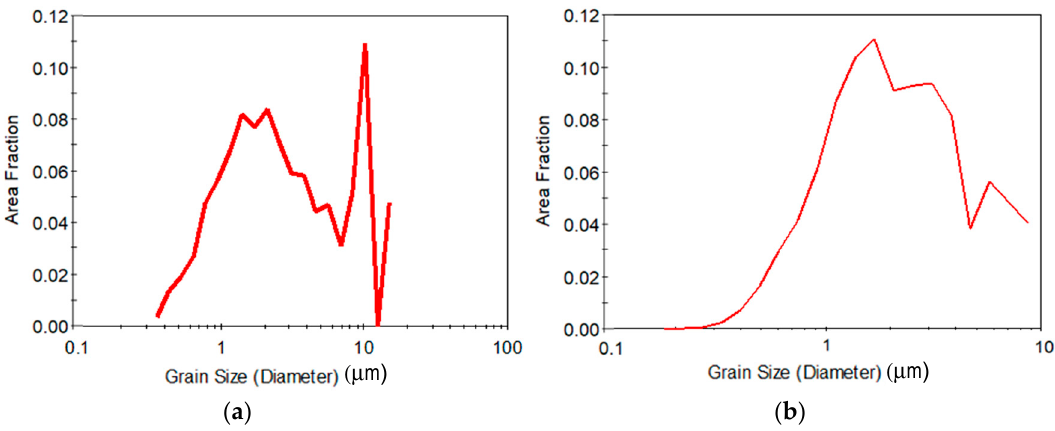
Figure 4. Distribution of the grain size after eight passes for ( a ) the sample pre-annealed at low temperature and ( b ) the sample pre-annealed at high temperature.